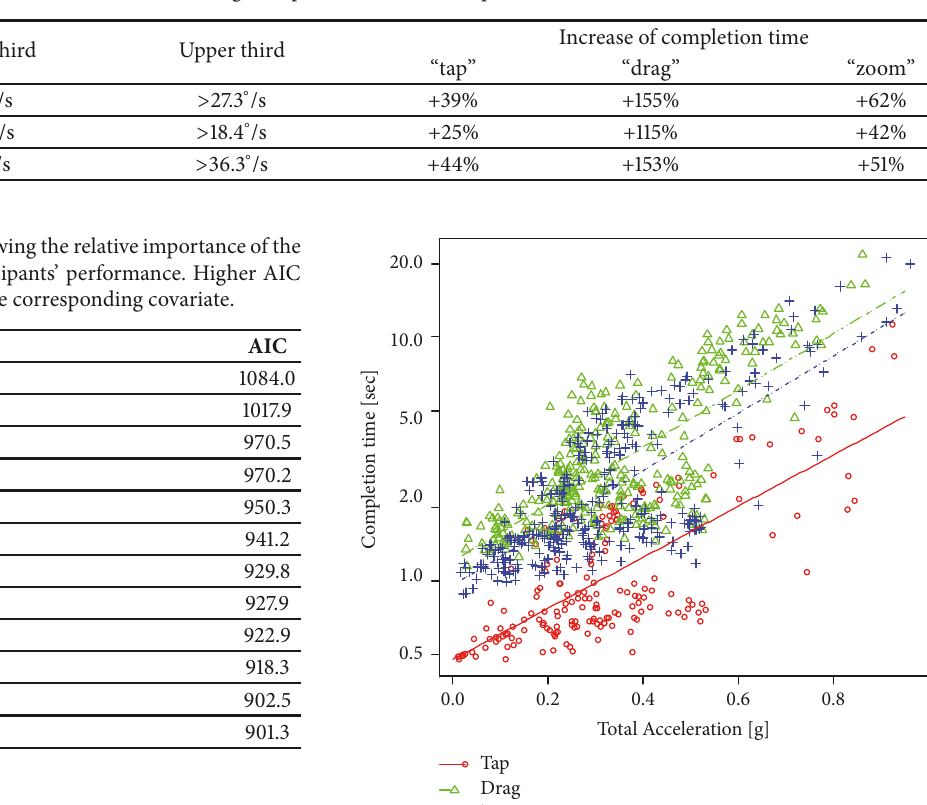
Table 1: Effect of angular speed on the task completion time.